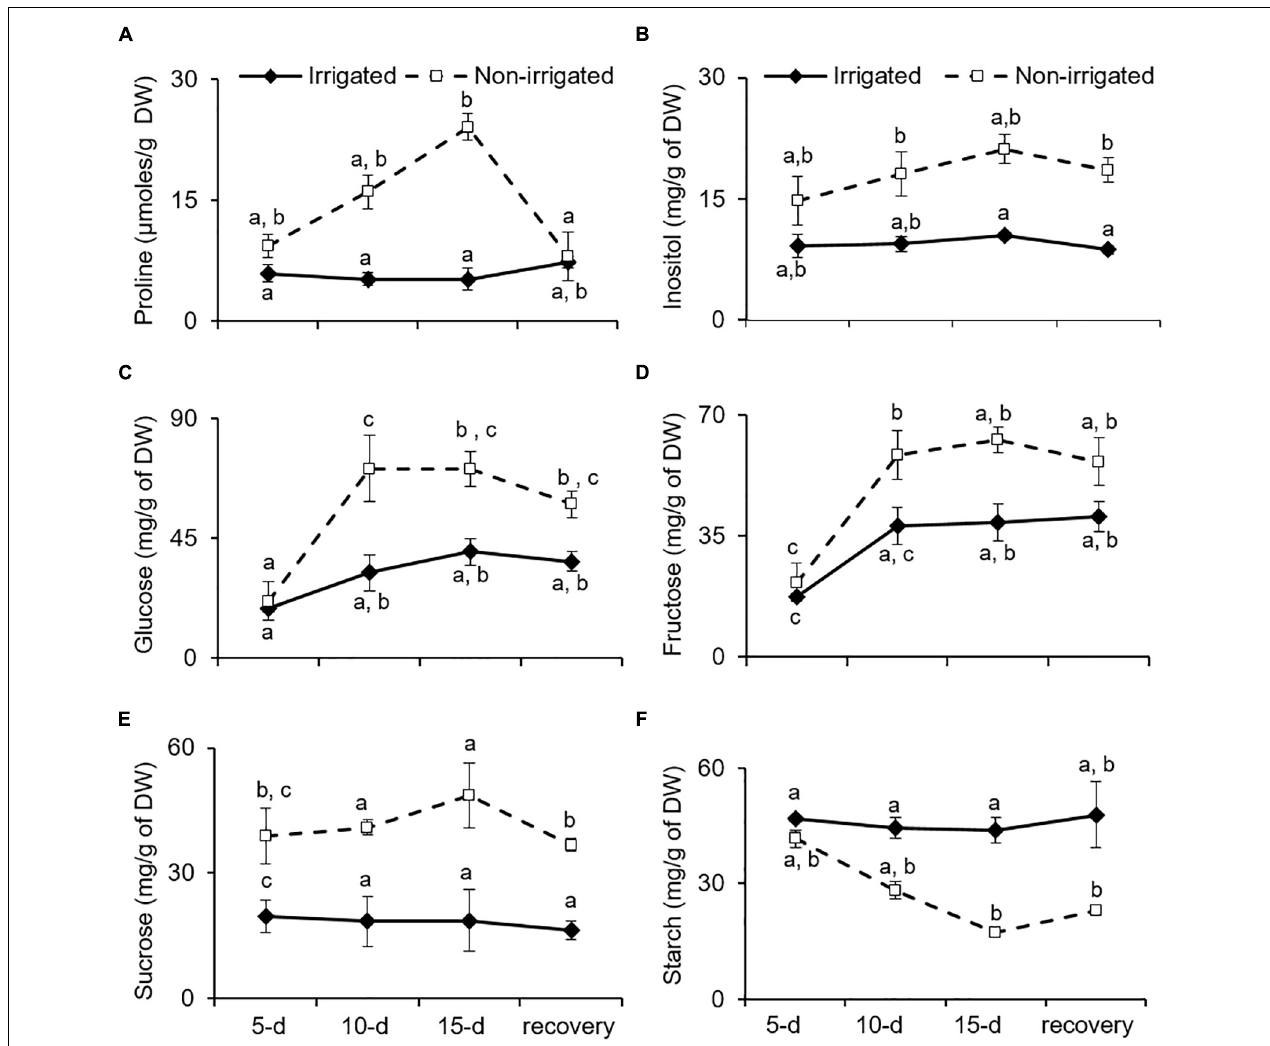
FIGURE 5 | Osmoprotectants tend to accumulate with water deficit in S. hexandrum . (A) Proline. (B) Insolitol. (C) Glucose. (D) Fructose. (E) Sucrose. (F) Starch. The data values show mean ± SE of three independent biological replicates. Lowercase letters represent statistical significance of differences between the mean values ( P < 0.05, Duncan’s multiple comparison